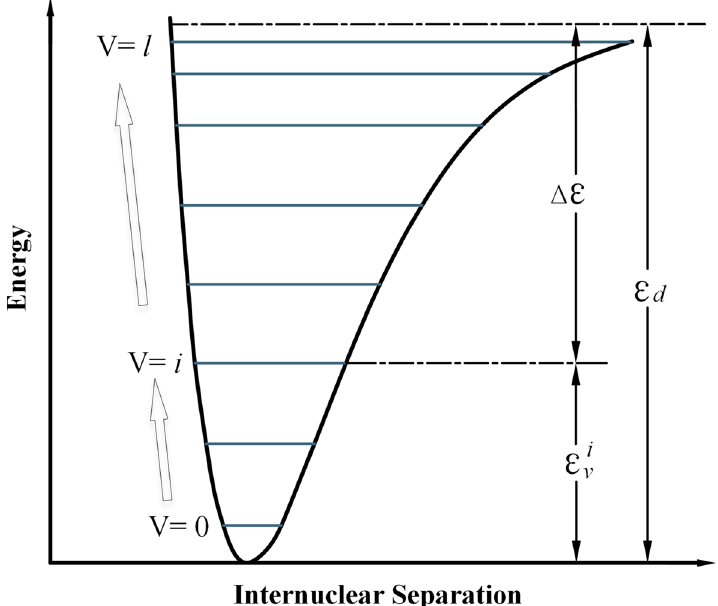
Fig. 13 Schematic of the coupled vibration-dissociation of a molecule [111,